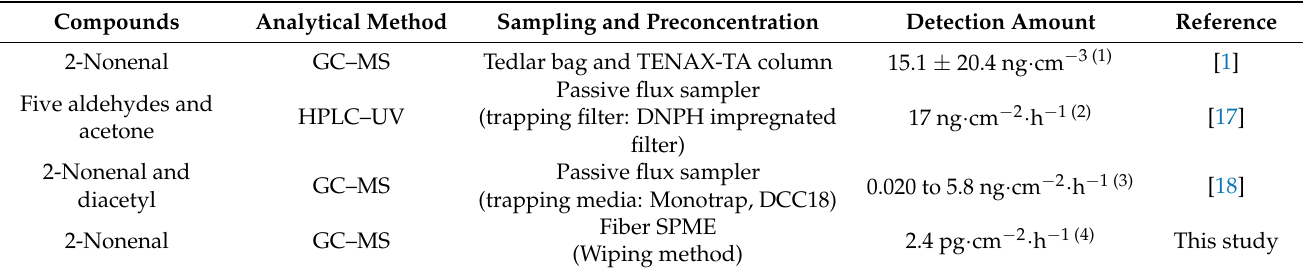
Table 4. Comparison of analytical methods for 2-nonenal and other aldehydes in body